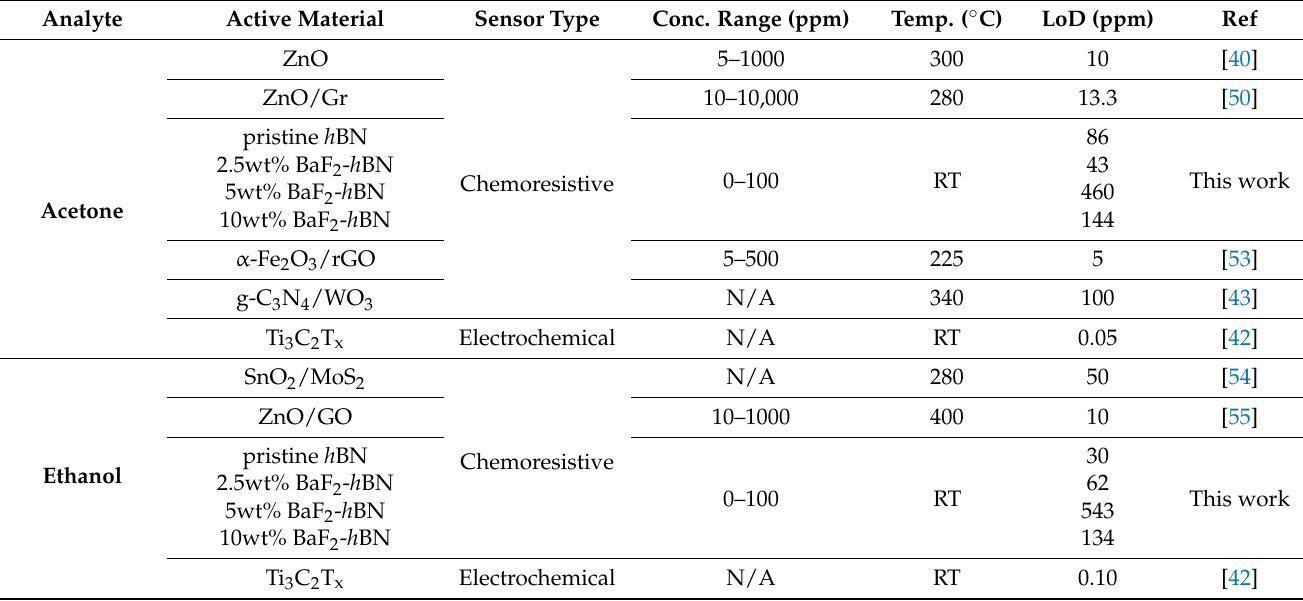
Table 2. Comparative sensor data for the h BN samples with other related materials for VOCs sensors.